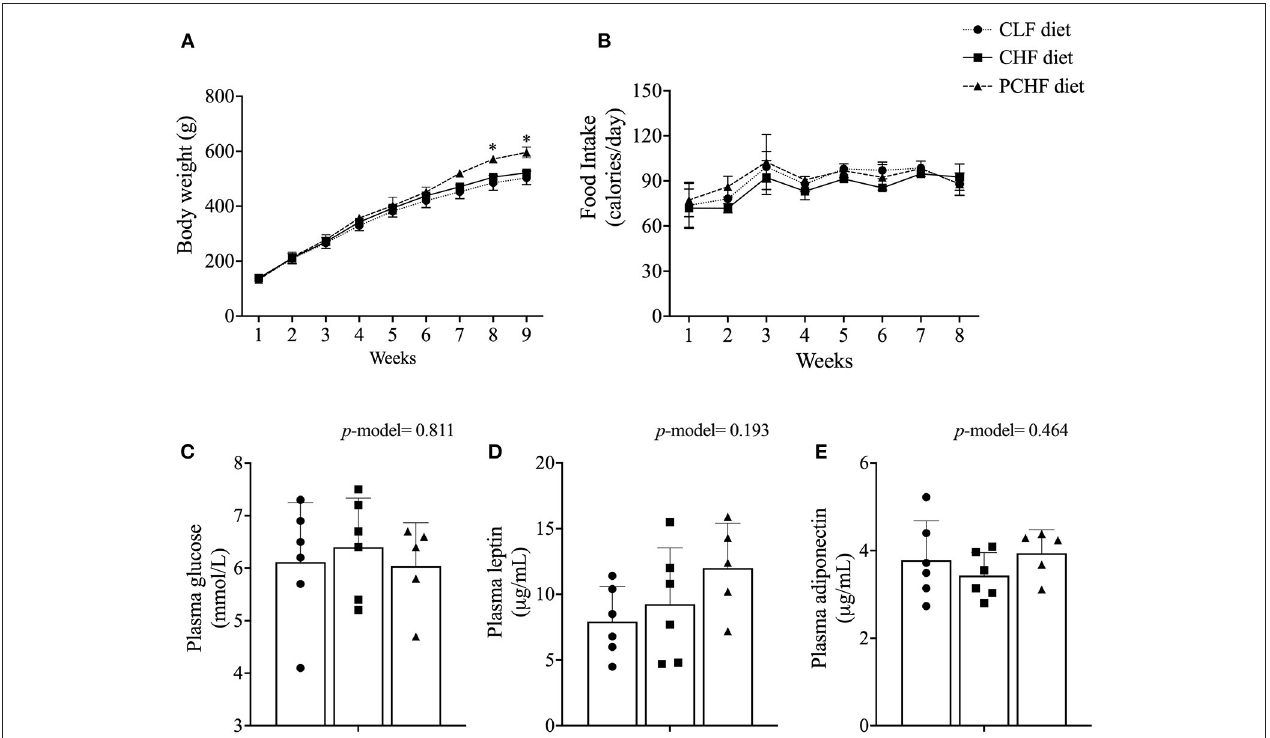
FIGURE 1 | (A) Body weight; (B) caloric intake; (C) non-fasting plasma levels of glucose; (D) leptin and (E) adiponectin of male Wistar rats fed the three experimental diets. Values are presented as mean ± SEM. *Means significantly different ( p < 0.05) from the CLF diet based on the one-way ANOVA test with the Duncan adjustment for multiple comparisons. CLF, control low-fat; CHF, control high-fat; PC, phosphatidylcholine; PCHF, PC